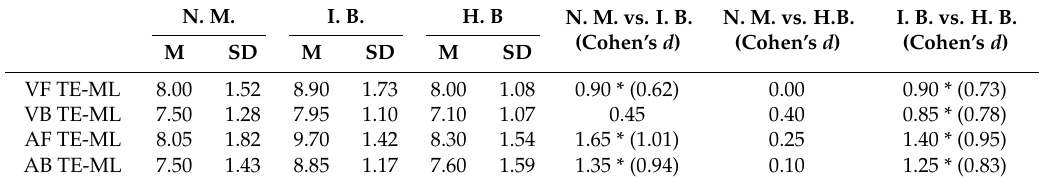
Table 9. Mean differences in two-error maximum lengths between language groups expressed as Cohen’s d. N. M.